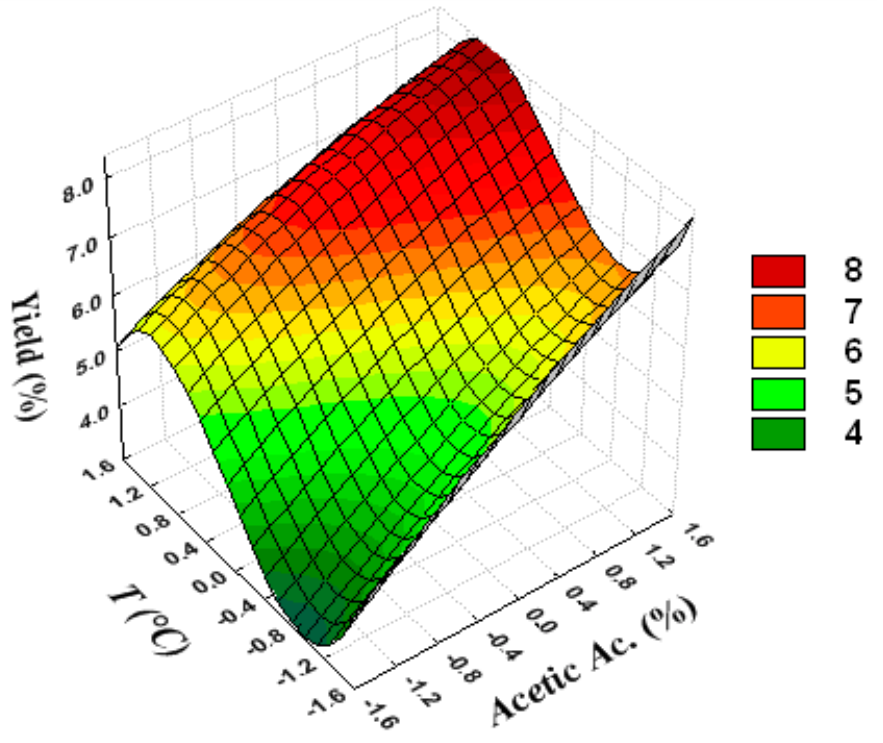
Figure 2. Response surface to show the mutual influence of temperature and acetic acid concentration on extraction yield.